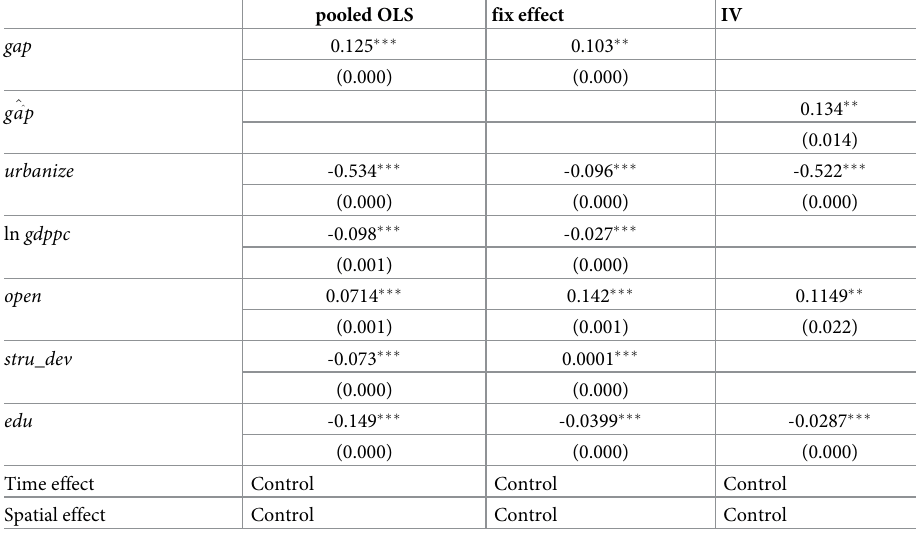
Table 6. Benchmark regression